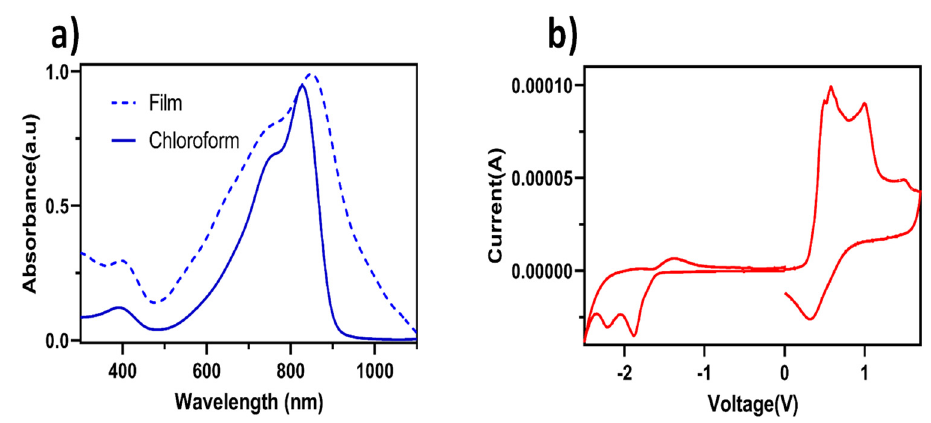
Figure 2. ( a ) UV-Vis spectrum; ( b ) Cyclic voltammogram of P(FDPP-TP) . In thin film, both peaks were red-shifted to 402 and 870 nm, indicating a favorable π - stacking between solid-state polymer chains, beneficial for charge carrier transport. The optical bandgap was 1.25 eV as calculated with the onset wavelength (1040 nm) of the polymer’s solid-state absorbance spectrum.